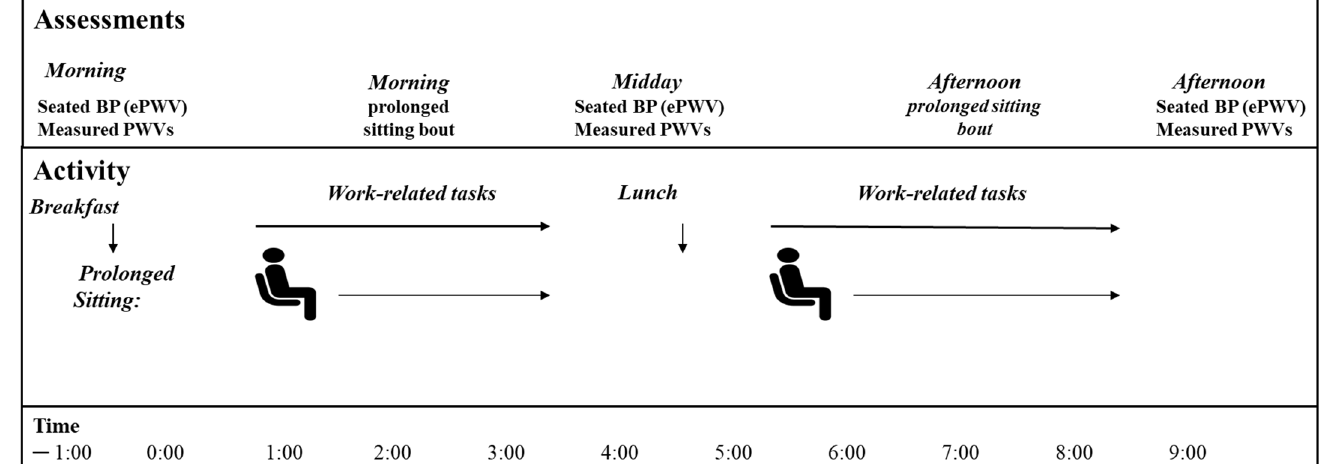
Figure 1. Experimental procedure. Participants arrived at our laboratory between 7:00 a.m. and 7:30 a.m. and performed a continuous uninterrupted prolonged sitting session. Blood pressure (BP) and measured pulse wave velocity (PWV) were completed in the morning, midday, and afternoon. Standardized meals (breakfast and lunch) were provided after morning and midday measurements.